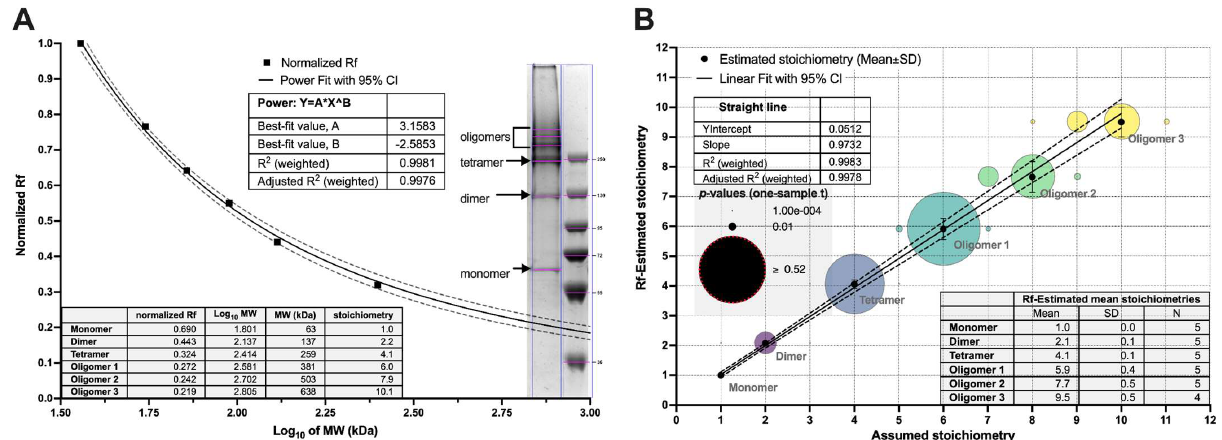
Figure 2. Determination of oligomers stoichiometry in non-reducing SDS-PAGE gels by analyzing relative front parameter ( R f ). ( A ). Exemplary non-linear regression of the standard molecular weights plotted against their normalized relative fronts. The power model parameters were used to derive an apparent molecular weight of the cytotoxin bands, and their stoichiometries averaged for several gel paths. ( B ). The linear correlation between R f -estimated and assumed stoichiometries for the dimer and oligomers. The R f value for each band was also compared to the theoretical stoichiometries by the one-sample t -test, and the resulting p -values are displayed on the bubble plot. Each band was compared to three or four most probable values. Dotted lines represent the 95% confidence intervals (CI) for the regression models.